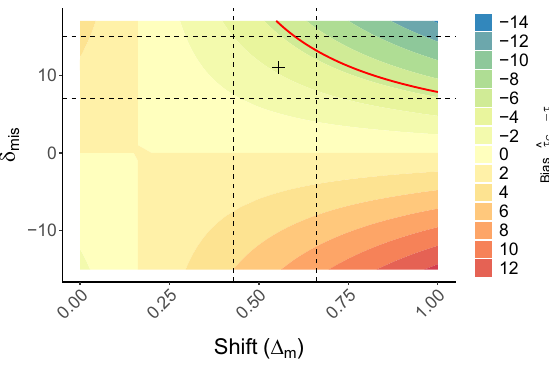
Figure 9: Sensitivity analysis of STAR data : considering the covariate g1surban is missing in the RCT. The black cross indicates that the point estimate value for the bias would be an expert that have the true sensitivity values ( −6.4 ) , and the true bias value is represented by the red line ( −7.08 ) . Dashed lines correspond to the 95% con fi dence intervals around the estimated sensitivity